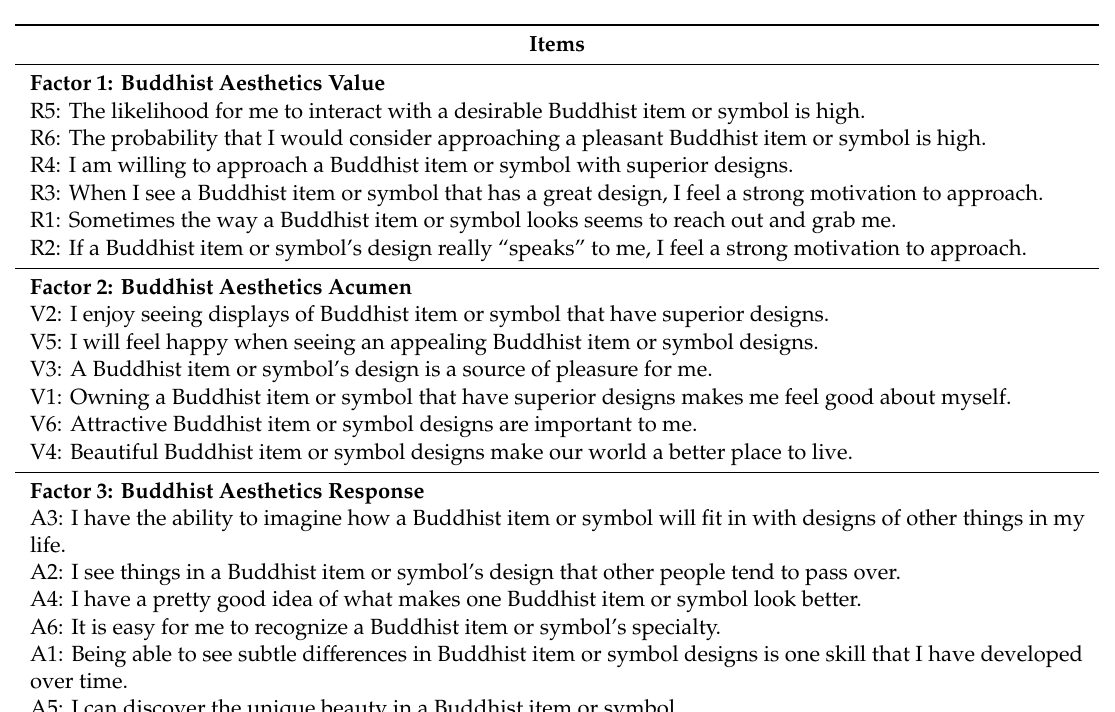
Table 2. Buddhist aesthetics scale items of the three